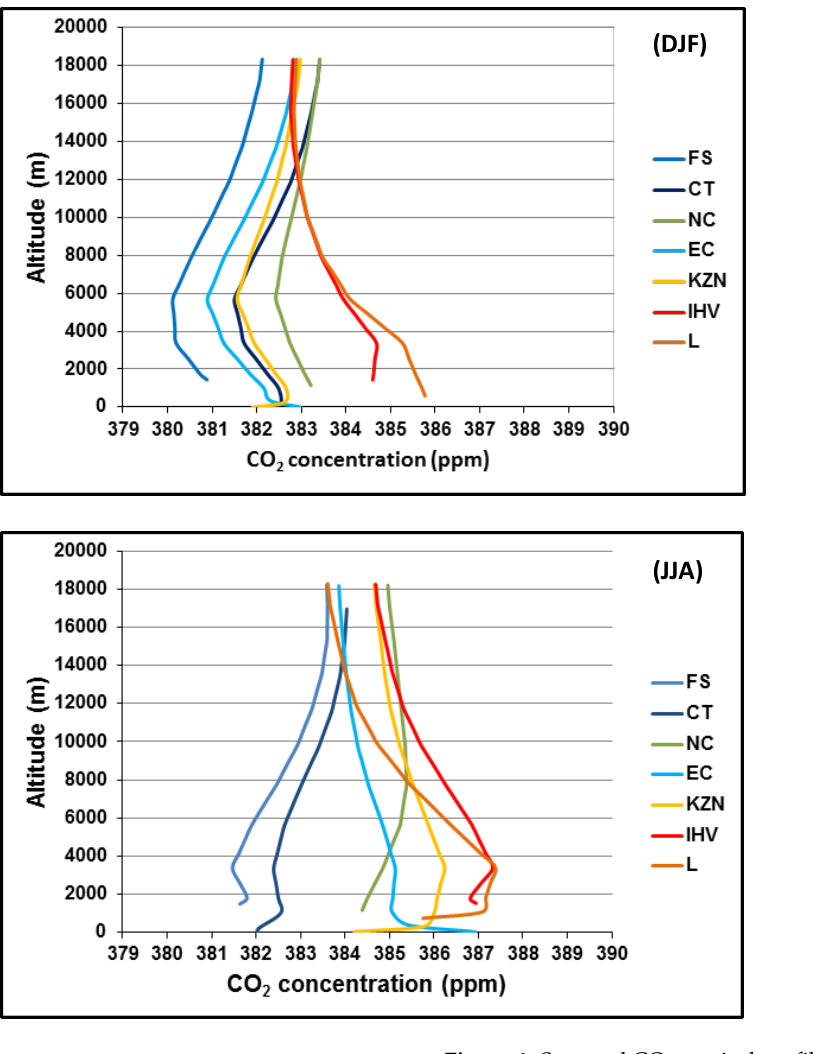
Figure 4. Seasonal CO 2 vertical profiles at selected areas in South Africa.